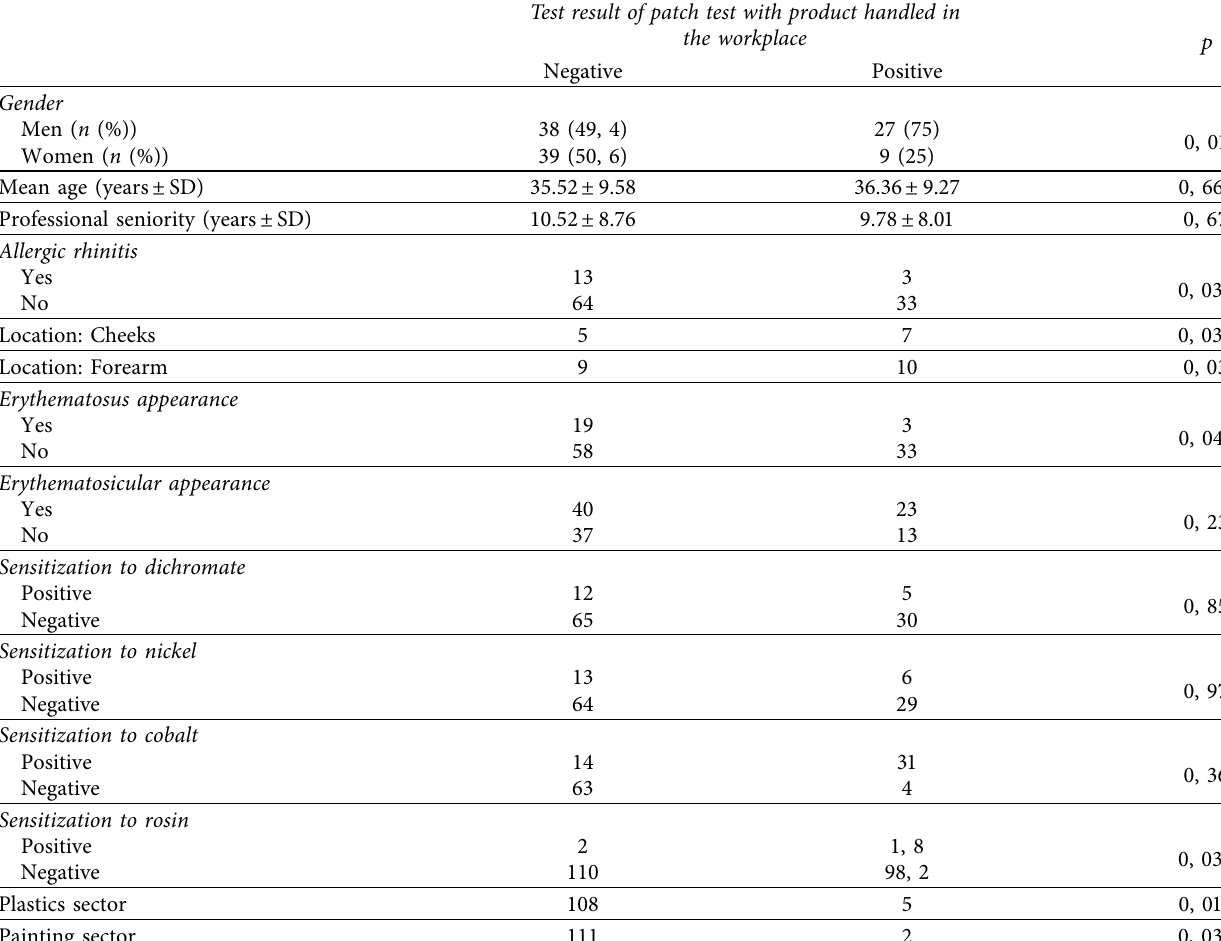
Table 5: Results of patch-tests with handled products and variables of interest. Test result of patch test with product handled in the